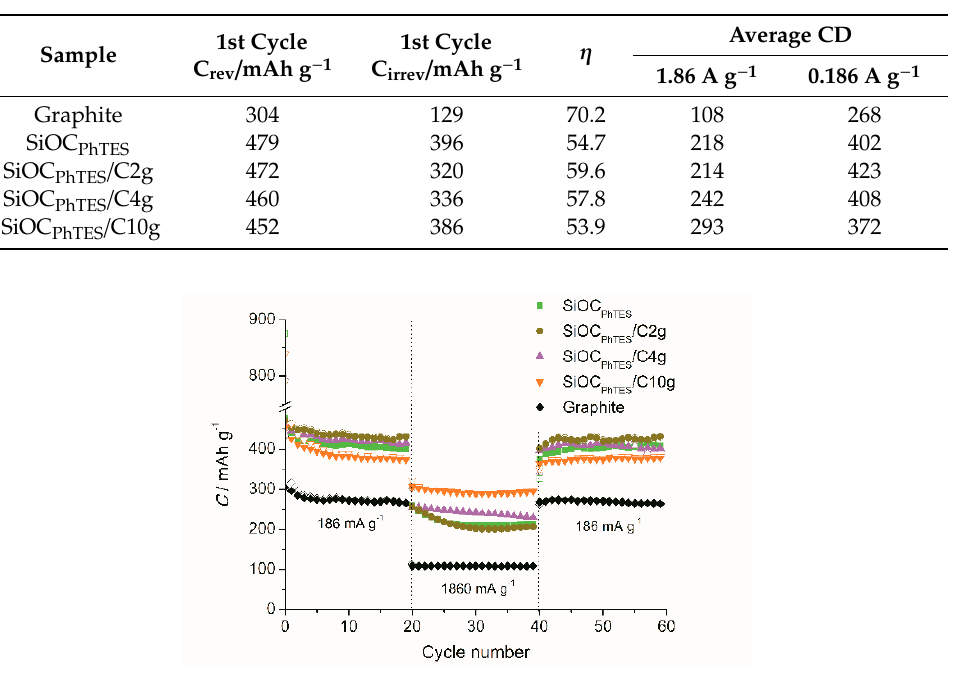
Table 4. Reversible C rev and irreversible C irrev capacity values of the first cycle upon polarization with 0.186 A g − 1 , Coulombic efficiency of the first cycle η and the average delithiation capacities CD of